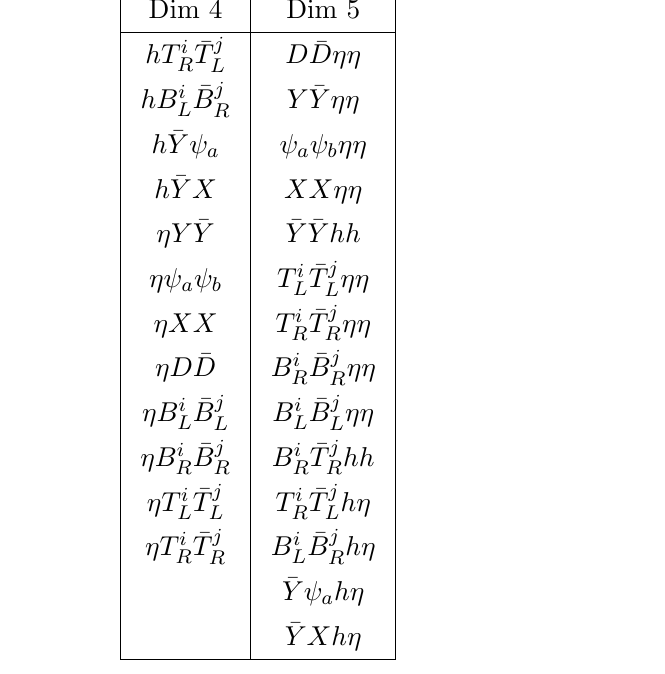
Table 9 . Dimension-4 and dimension-5 operators of fermions for LHC phenomenology. Here, the superscript i refers to unprimed, primed, or double primed for the three generations of top and bottom quarks, and the subscript a ranges over 1 ; 2 ; 3 for the three neutral fermions.